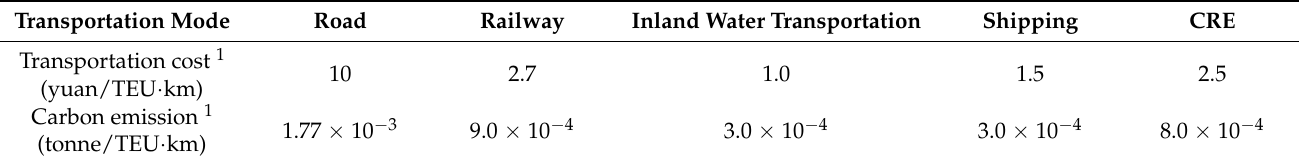
Table 2. Transportation costs and carbon emissions under different transportation modes.